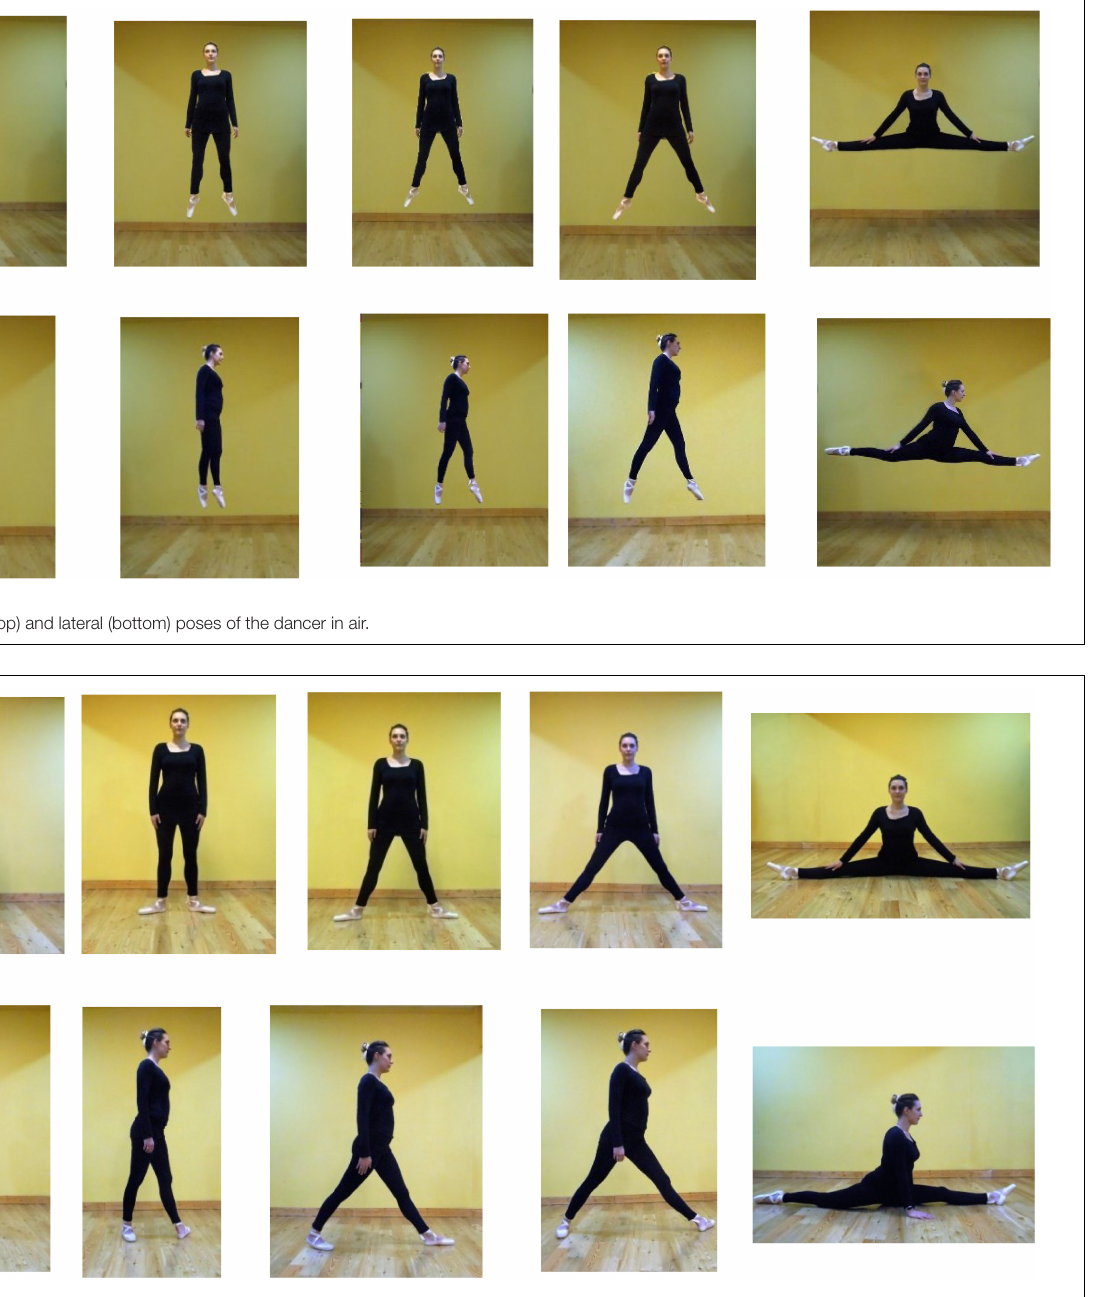
FIGURE 2 | Frontal (top) and lateral (bottom) on-ground poses of the